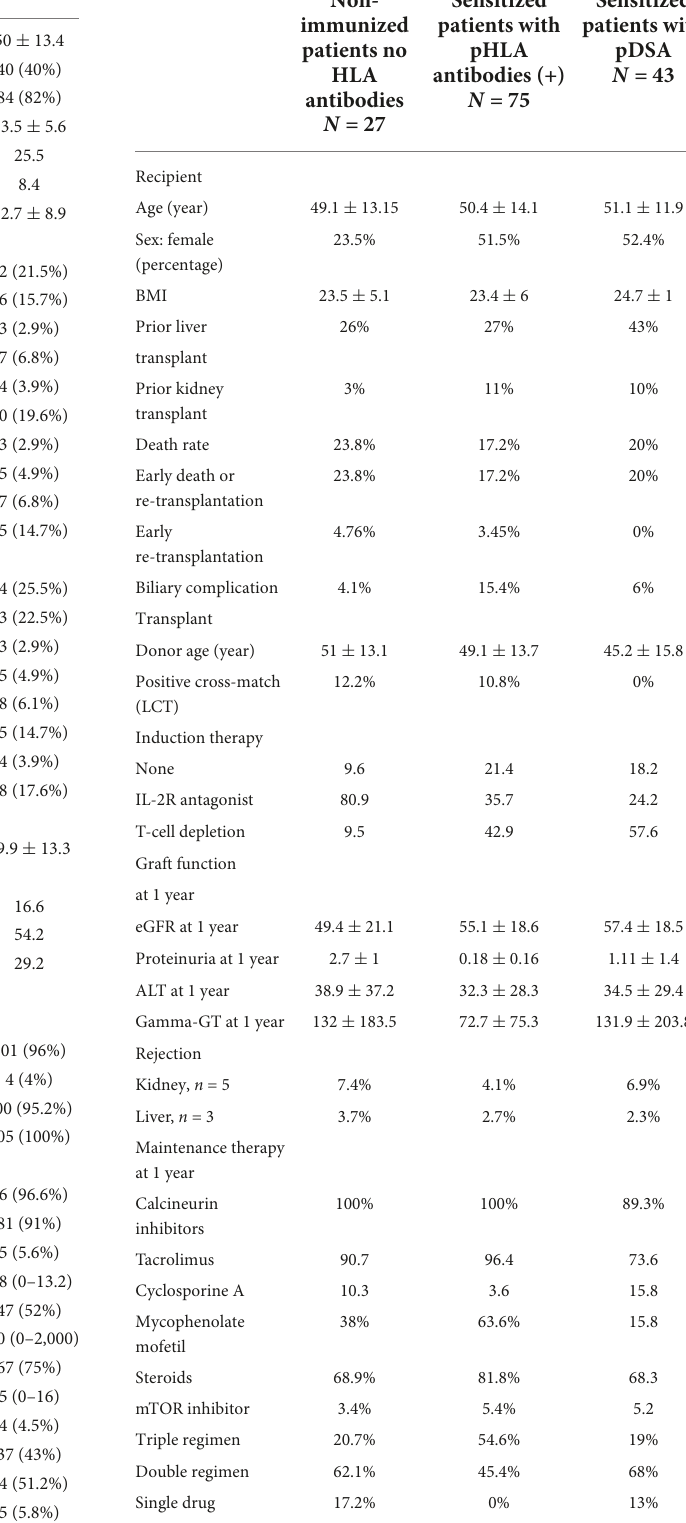
TABLE 1 Patient characteristics. TABLE 2 Patient characteristics, by DSA